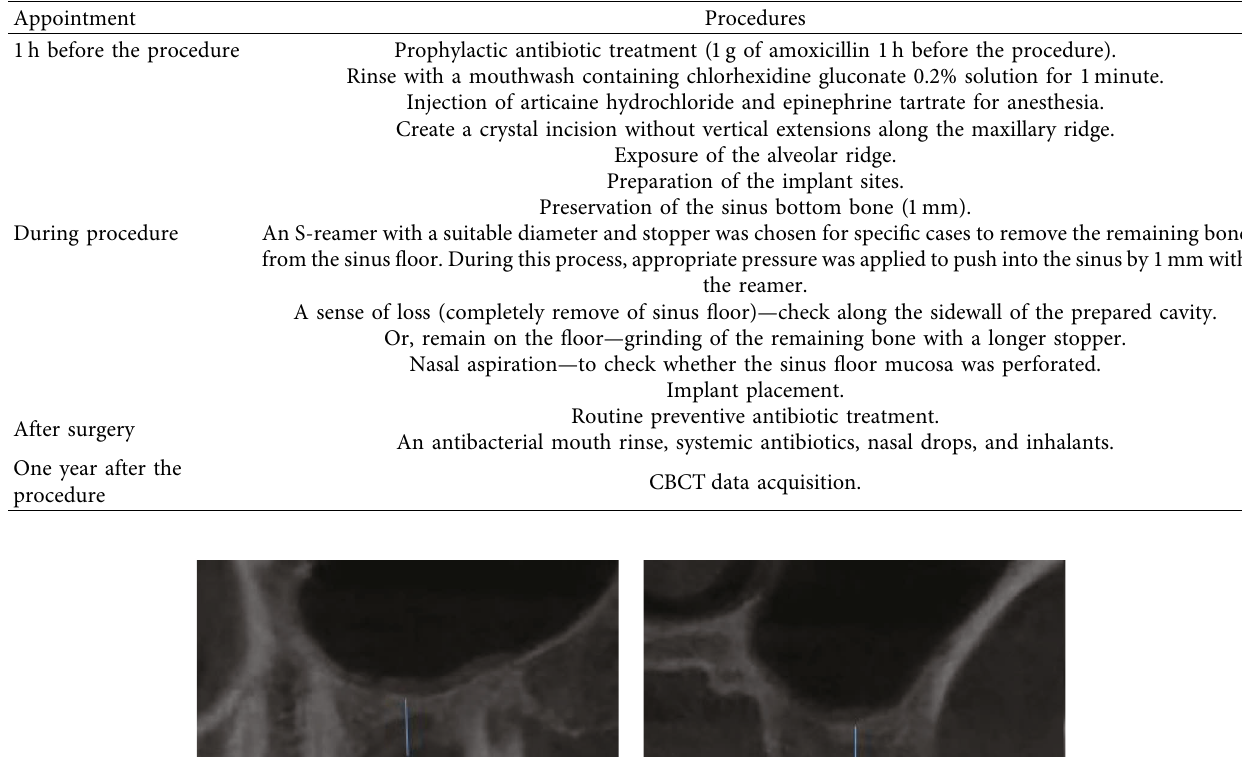
Table 2: Protocol designed for the study.